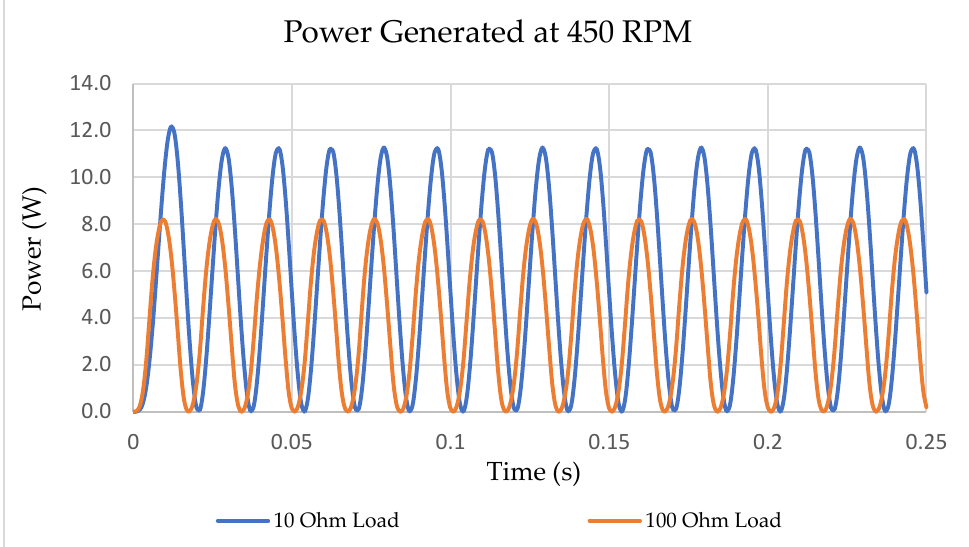
Figure 15. Power generated at 450 RPM. At 450 RPM generator was able to generate a peak power of 11.2 W under a 10-ohm load condition and 8.2 W under a 100-ohm load condition. Figure 16 shows the output power generated at 800 RPM.